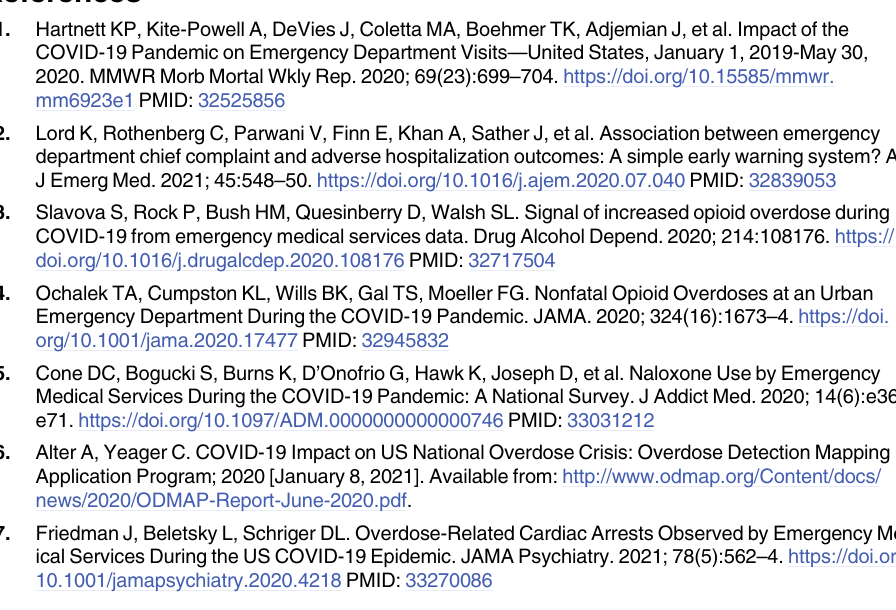
S3 Fig. Visit counts for SUD: OUD, AUD, and other SUD. (TIF) S4 Fig. Proportion of overall visits for SUD: OUD, AUD, and other SUD. (TIF) S1